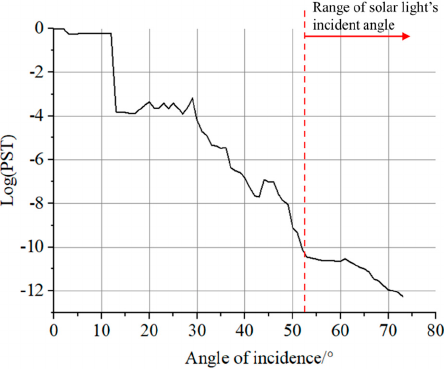
Figure 13. PST curve considering whole-satellite model.